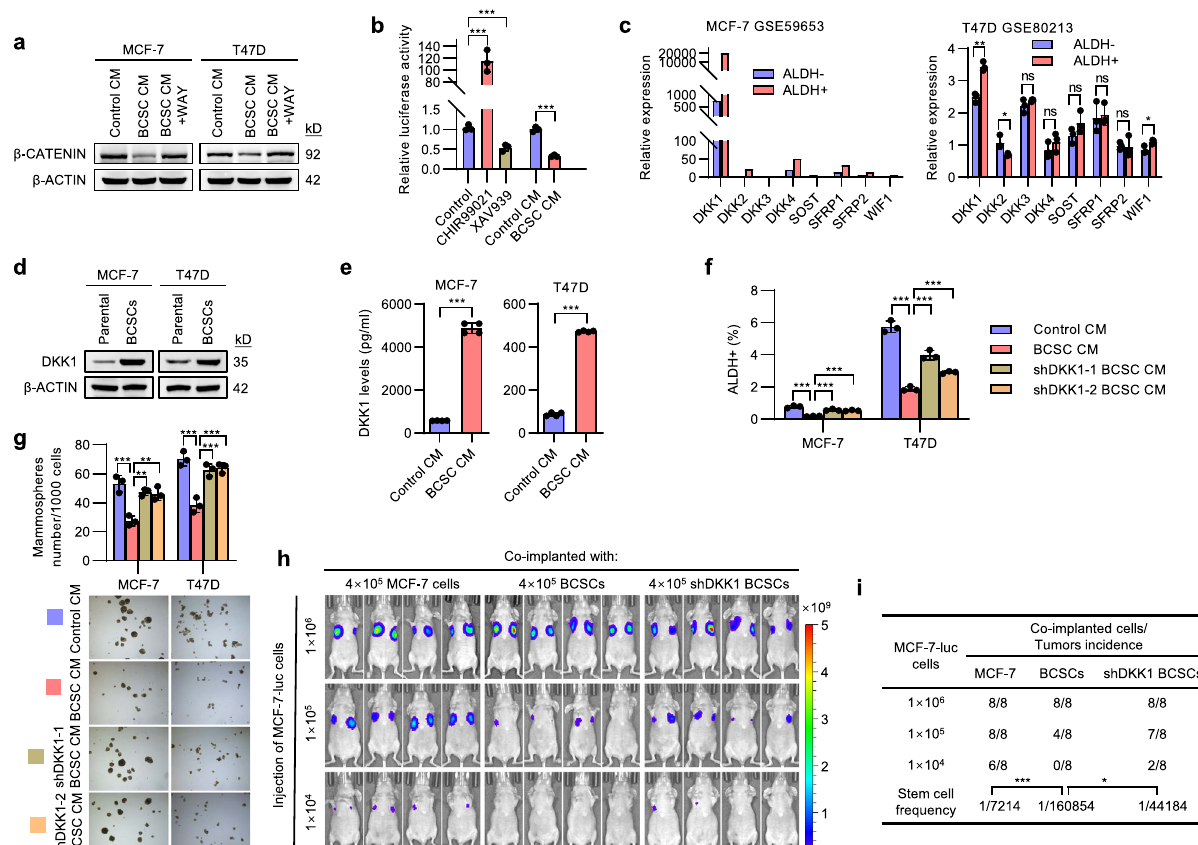
Fig. 2 BCSC-secreted DKK1 shrinks the stem cell pool. a Immunoblot assessment of β -CATENIN protein levels. Cells were cultured with the CM obtained from respective parental cells or mammosphere-enriched BCSCs and treated with DKK1 Inhibitor WAY262611 (1 μ M) or vehicle. b Luciferase activities of the β -CATENIN reporter 8 × TOP Flash in MCF-7 cells cultured with the respective CM obtained from parental cells or mammosphere-enriched BCSCs, the β -CATENIN agonist CHIR99021 (1 μ M) or inhibitor XAV939 (1 μ M) served as the positive or negative control, respectively. c The gene expression pro fi